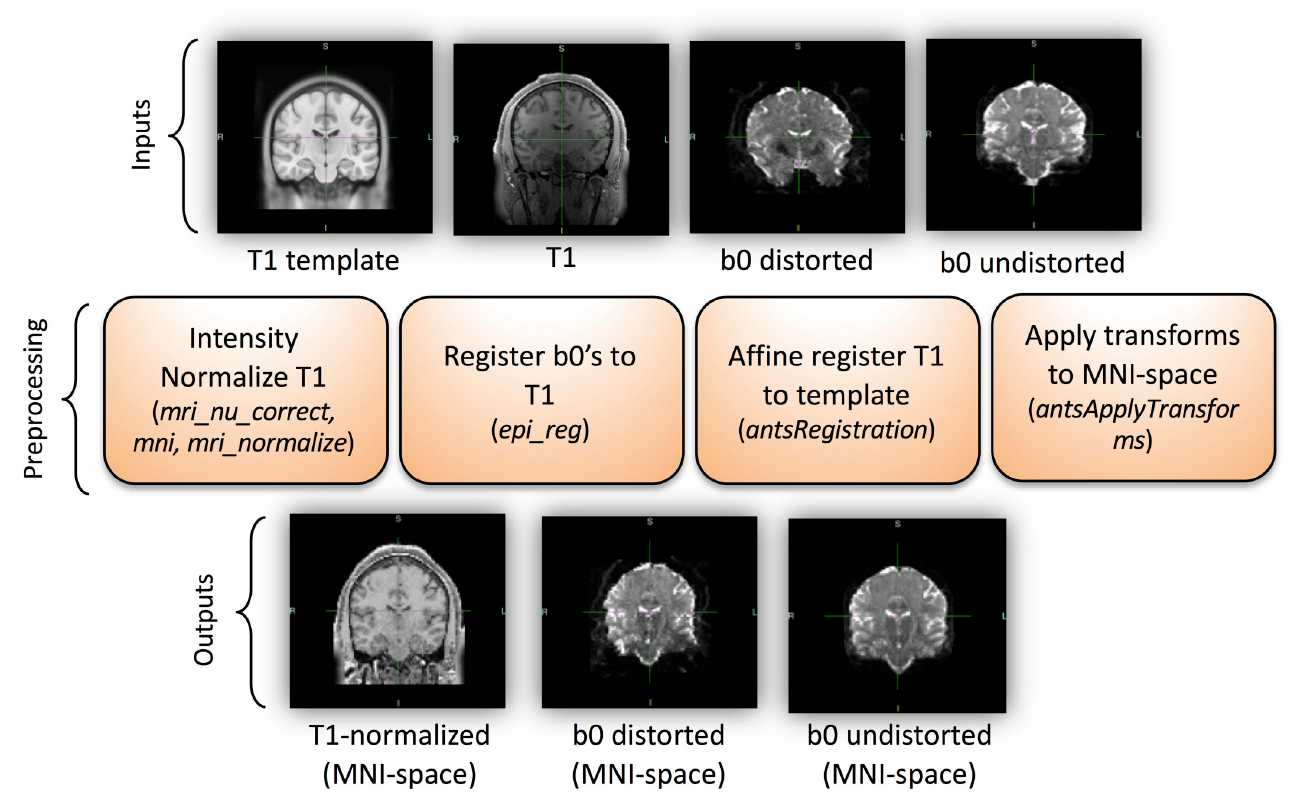
Fig 3. The preprocessing pipeline. This figure show data preparation prior to network learning (Fig 4). The pipeline inputs includes a T1 image as well as distorted and undistorted b0 images, and the outputs are all images aligned in MNI